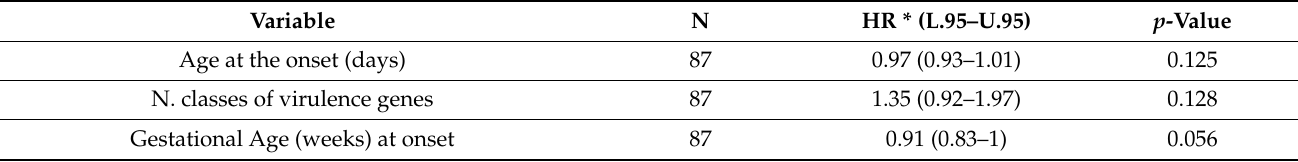
Table 7. Multivariate regression analysis on the 28-day mortality